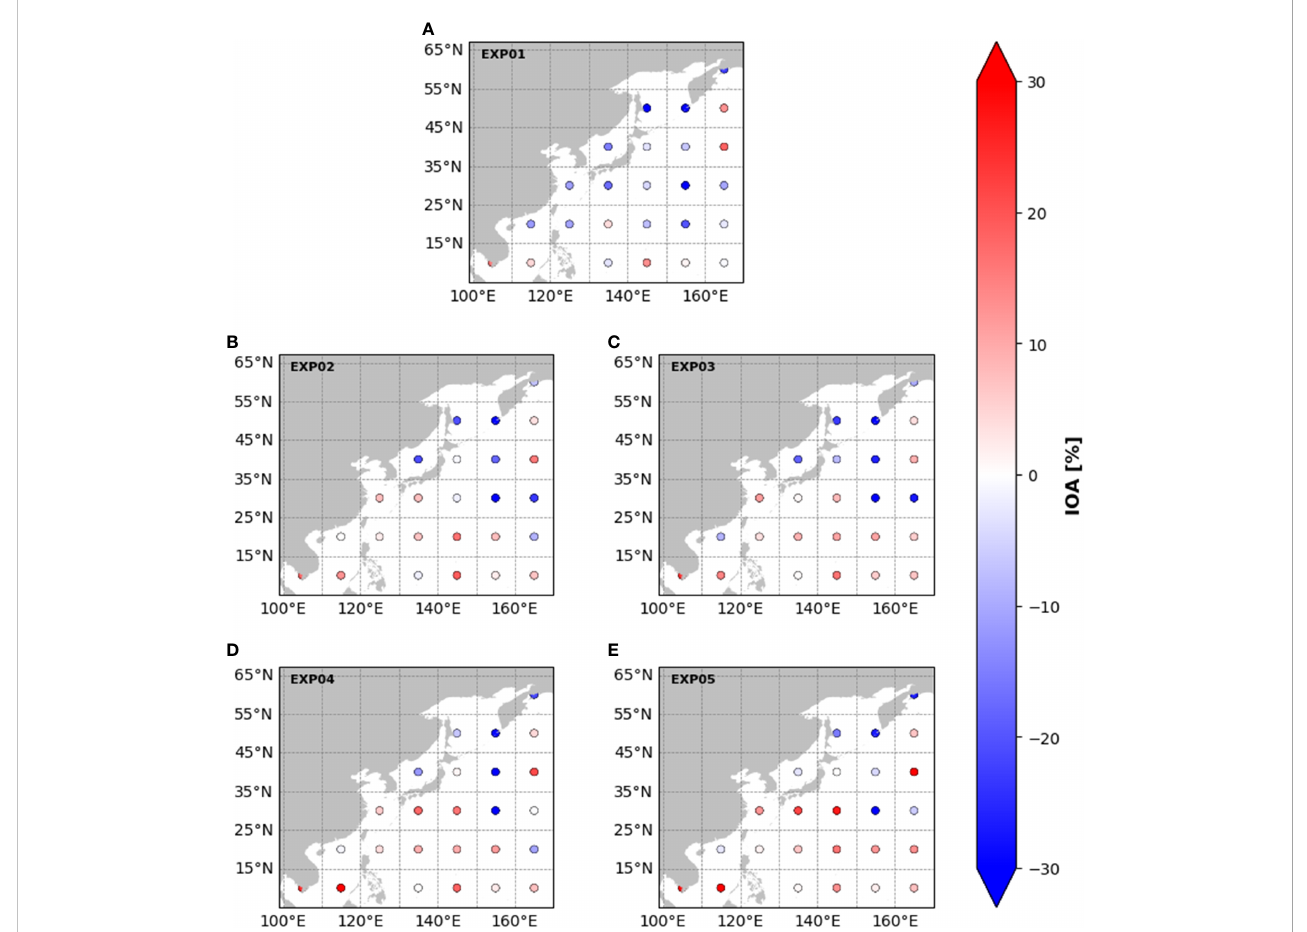
FIGURE 6 Distribution of mean IOA for salinity at subsurface layer. (A-E) represent the results of EXP01-05,